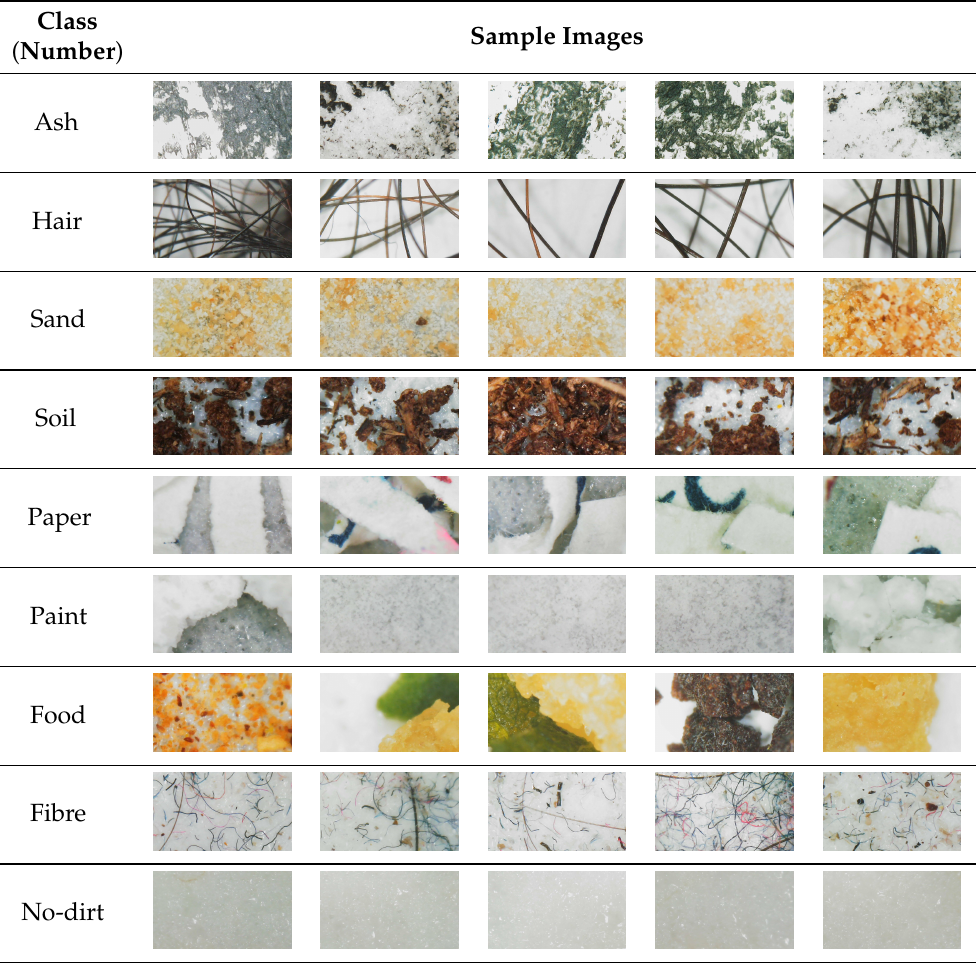
Table 1. The classes of identified domestic